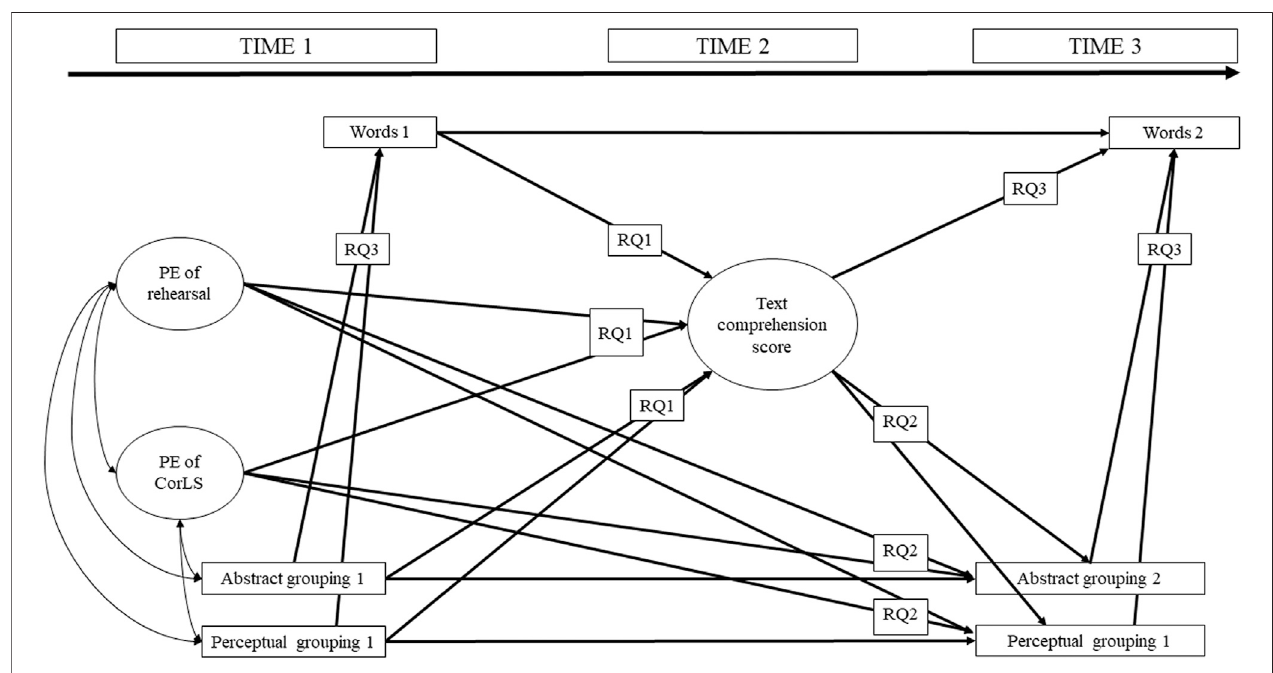
FIGURE 1 | Theoretical model and study